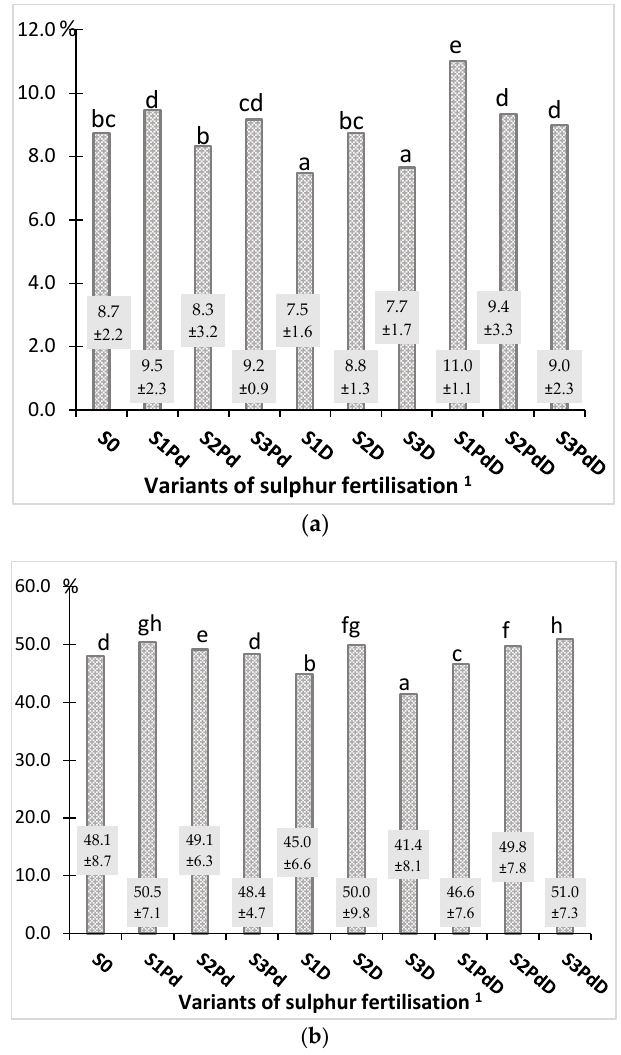
Figure 12. ( a ) Calcium harvest index on average for variants of sulphur fertilisation; ( b ) Magnesium harvest index on average for variants of sulphur fertilisation. 1 See Table 2; Means followed by the same letter are not statistically different at the α = 0.05 level. ± — standard deviation.